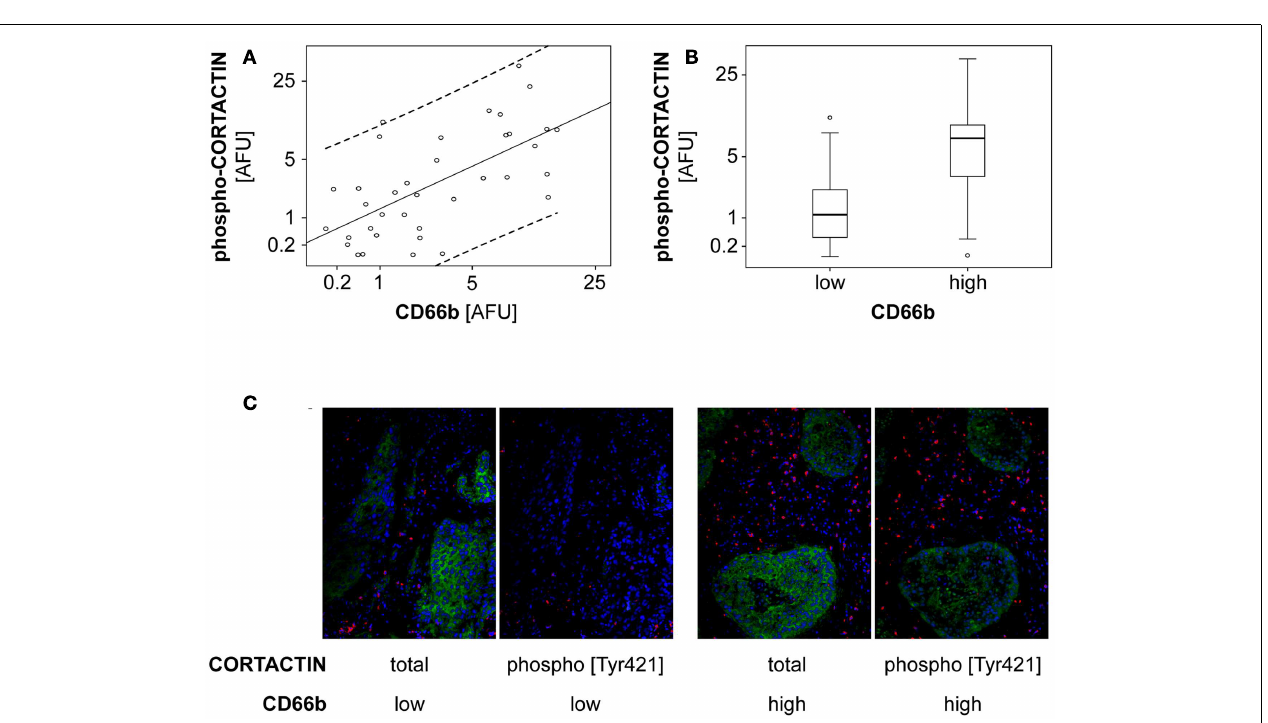
( p < 0.001; ρ = 0.620). (B) The level of CORTACTIN phosphorylation in patients with low ( n = 19) versus high ( n = 18) neutrophilic infiltration. Shown are the medians (black lines) and percentiles (25th and 75th) as vertical boxes with error bars; outliers are indicated as small circles. Statistical analysis was performed with the χ 2 test ( p = 0.029). (C) Representative micrographs (magnification = 200 × ) of CORTACTIN phosphorylation in patients with low versus high neutrophilic infiltration. Green, CORTACTIN or phospho-CORTACTIN; red, CD66b (neutrophils); blue pseudocolor, DRAQ5 (nuclear